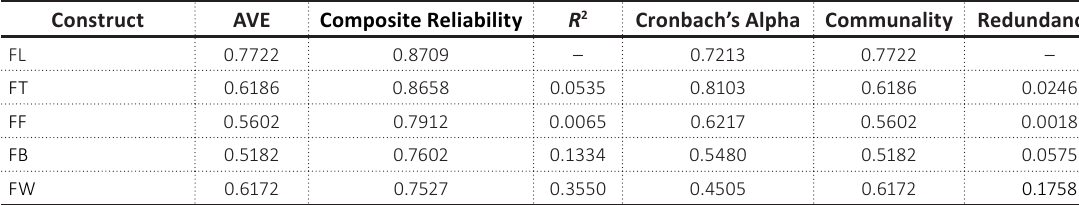
Table 3. Validity and reliability measures of constructs Construct